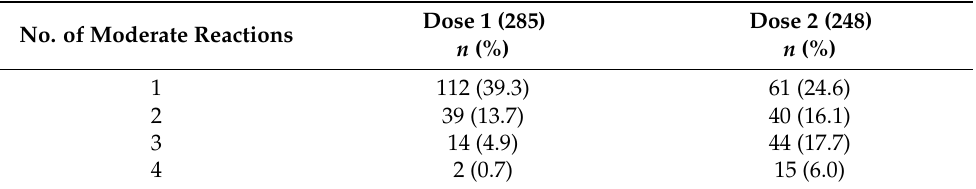
Table 5. Prevalence of reporting of one of more moderate adverse reactions interfering with activities following the first and second vaccination doses, among subjects without severe reactions.